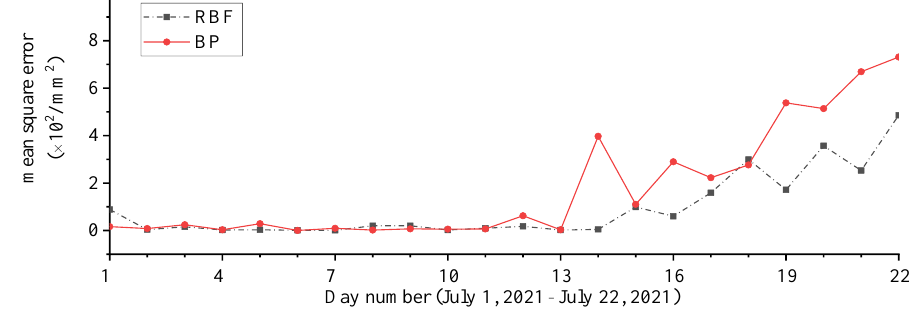
Figure 11. Comparison of model calibration errors.